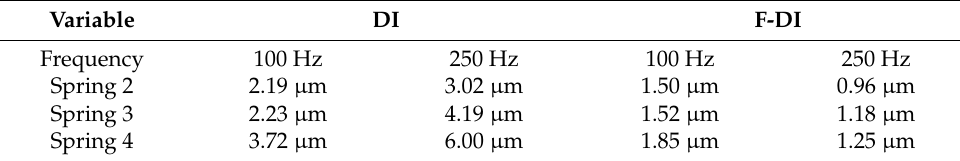
Figure 14. Feedforward experimental in 250 Hz at different forces: ( a ) spring 2; ( b ) spring 3; ( c ) spring 4. Table 4. Maximum error between F-DI compensator and DI compensator.